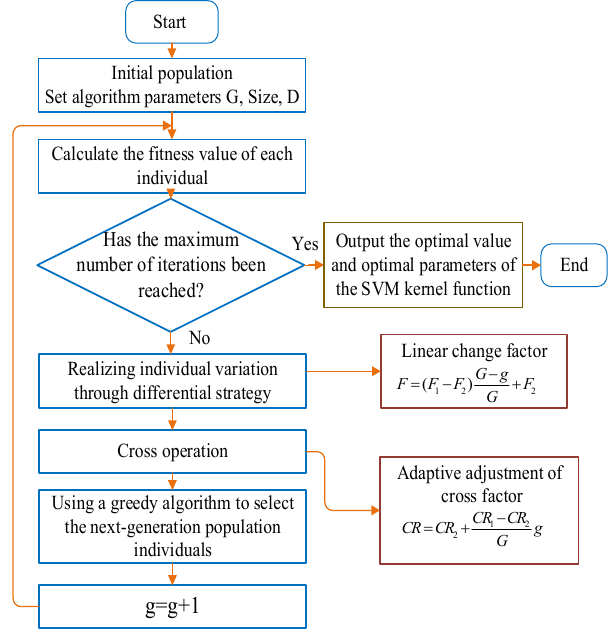
Figure 1. DE algorithm optimization SVM flow chart.